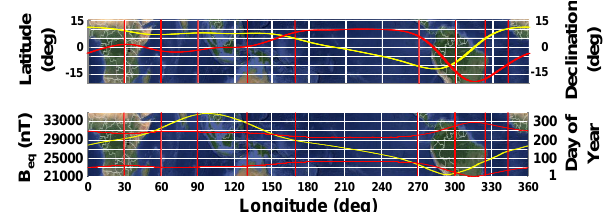
Figure 2. (top) latitude of magnetic equator (yellow, left vertical axis) and corresponding Figure 2. (top) Latitude of magnetic equator (yellow, left vertical declination (red, right vertical axis), for each longitude. (bottom) strength of the magnetic field axis) and corresponding declination (red, right vertical axis) for (yellow, left vertical axis) and two days of the year for approximate alignment between the each longitude. (bottom) strength of the magnetic field (yellow, left magnetic field and the terminator line at the magnetic equator, for each longitude (red, right vertical axis) and 2 days of the year for approximate alignment be- axis). The vertical red lines separate the adopted longitude sectors. tween the magnetic field and the terminator line at the magnetic equator for each longitude (red, right axis). The vertical red lines separate the adopted longitude